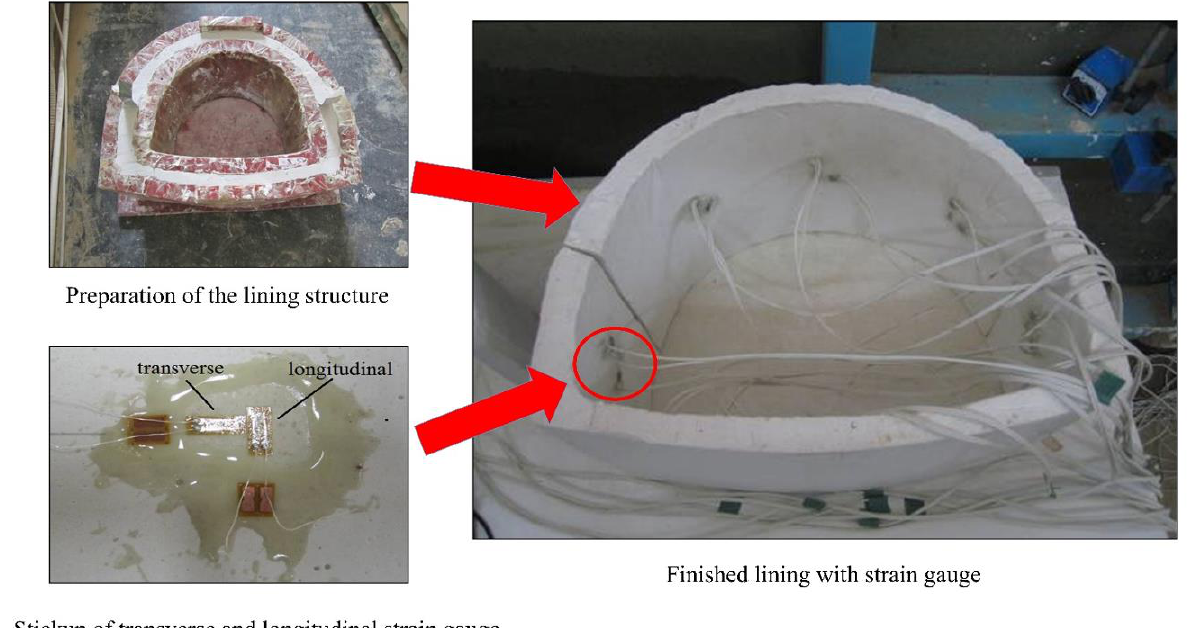
Figure 7. Preparation of the lining structure. Table 3. Physical and mechanical parameters of tunnel